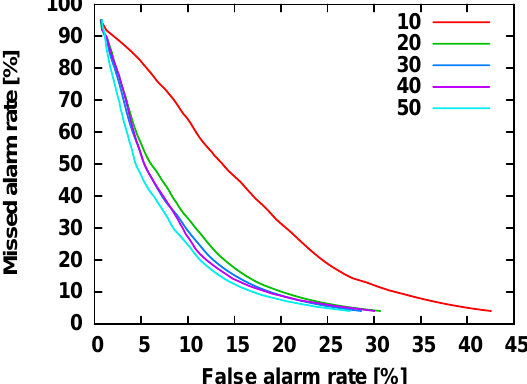
Figure 11. ROC curves for detection of internal masqueraders (a) and external masqueraders (b) for the number of training sequences. All other parameters are the same as those in Figure